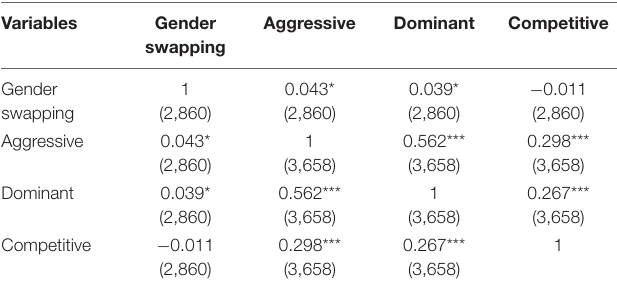
TABLE 2 | Correlation analysis summary of gender swapping and three types of hyper-masculine